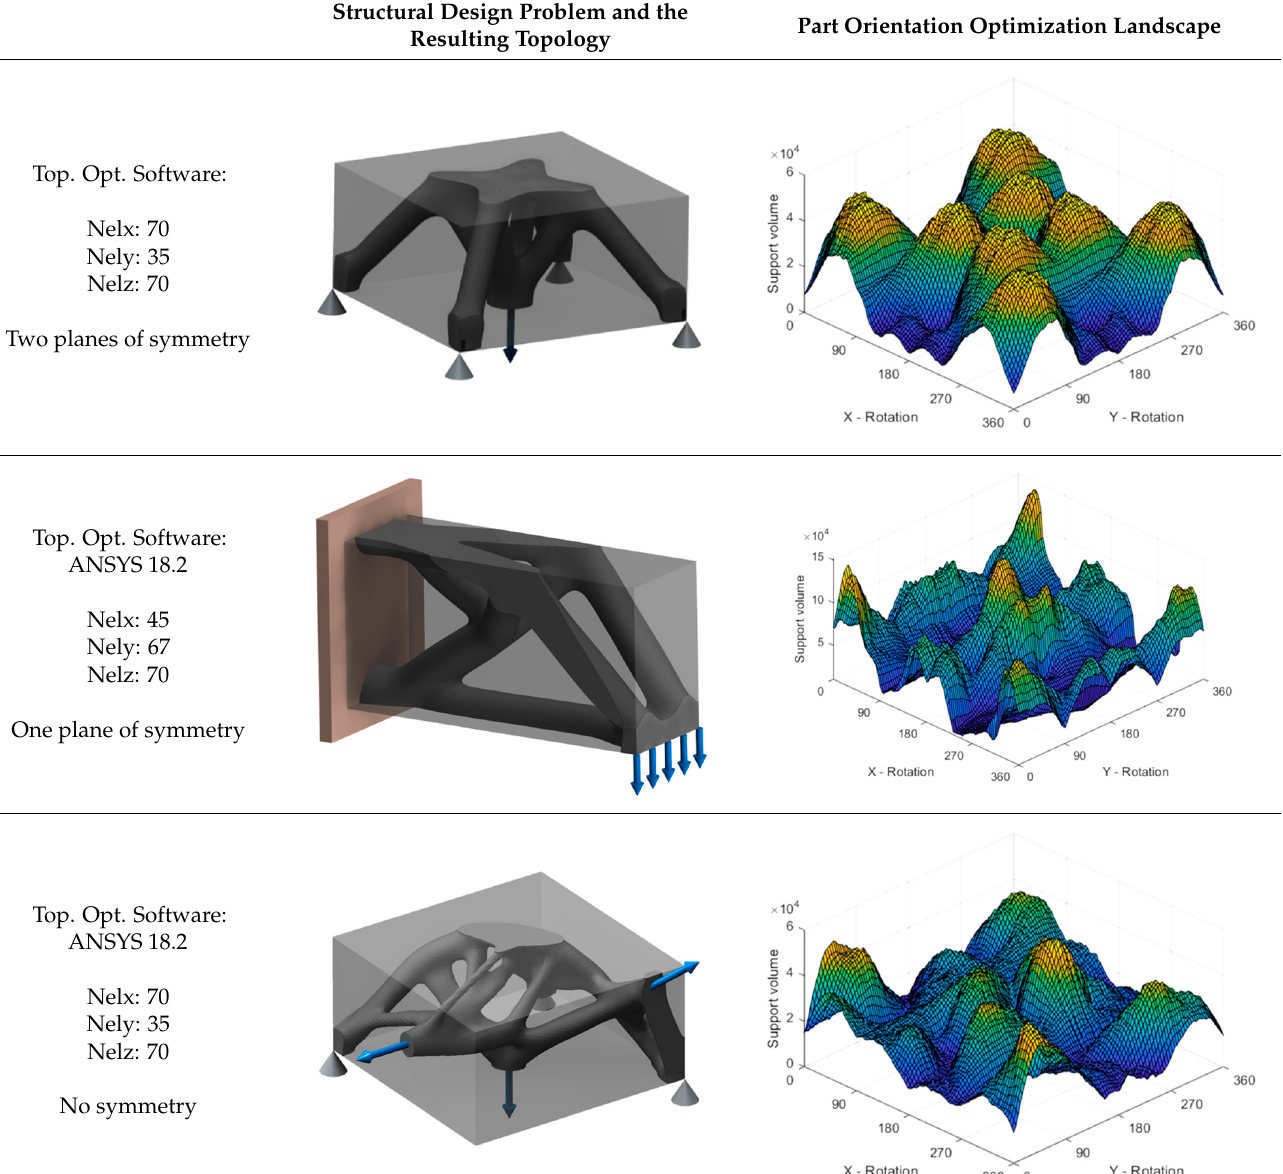
Table 1. Three structural design problems, results of the topology optimization, and corresponding landscapes of the orientation optimization.